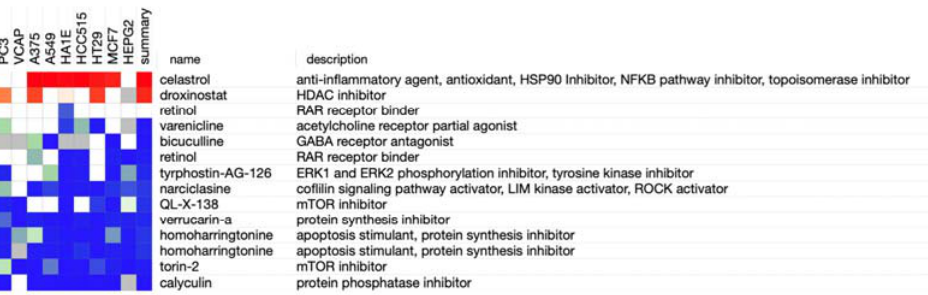
Figure 6. Potential therapeutic agents were identified by the CMap analysis. CMap: connectivity map.